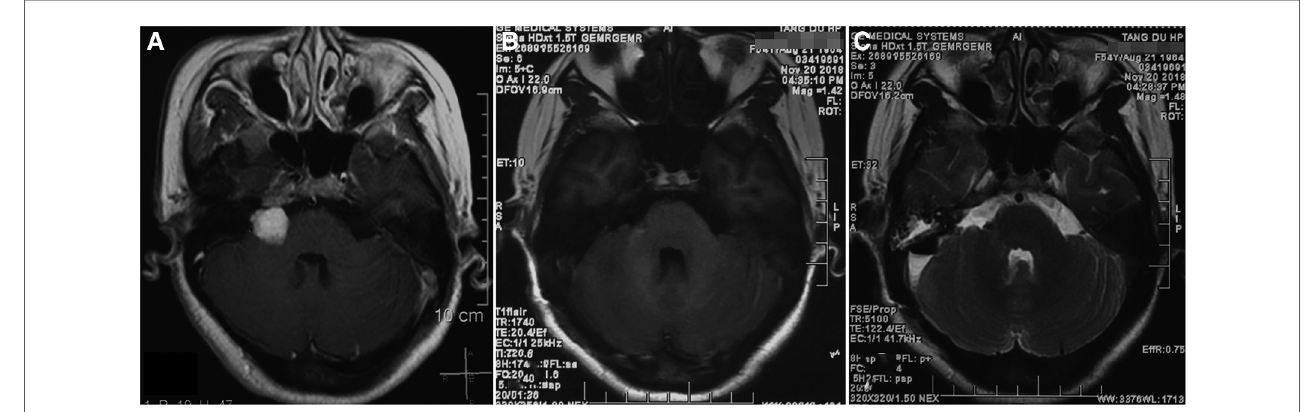
FIGURE 1 MRI features of the patient before and after craniotomy. ( A ) Axial T1-weighted MRI with contrast showing a 1.5 cm*1.2 cm*1.3 cm right-sided vestibular schwannoma before craniotomy surgery; ( B ) Postoperative axial T1-weighted MRI with contrast revealing total resection of tumor; ( C ) Postoperative axial T2-weighted MRI showing no ischemic lesion in the right AICA territory.